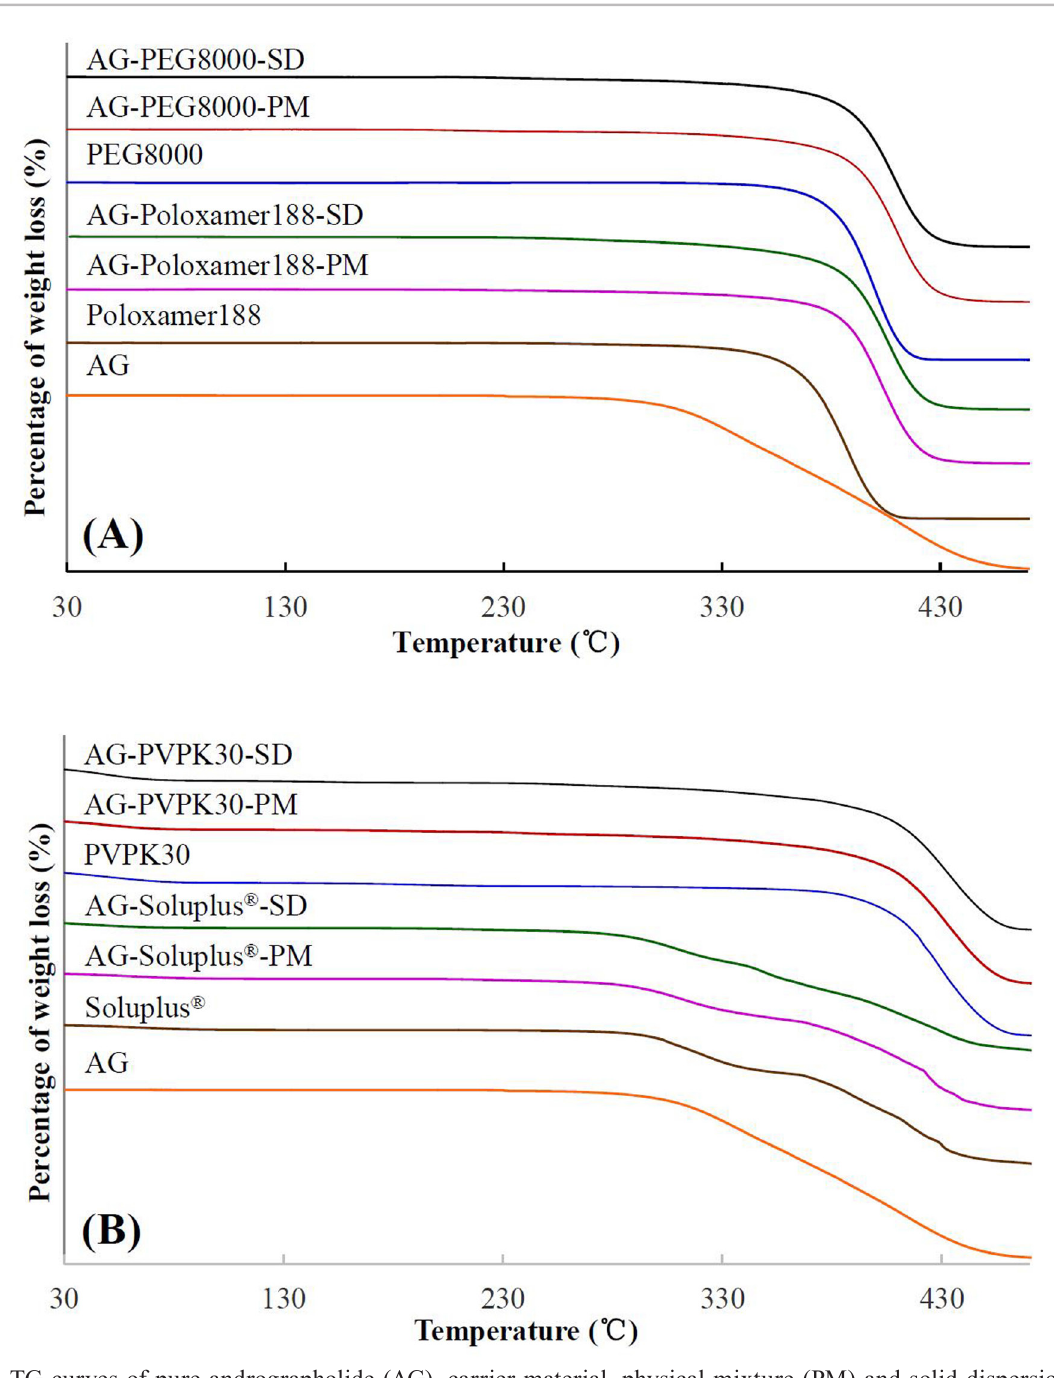
FIGURE 2 - TG curves of pure andrographolide (AG), carrier material, physical mixture (PM) and solid dispersion (SD) (A) PEG8000 and Poloxamer188 as carrier materials, (B) PVPK30 and Soluplus ® as carrier